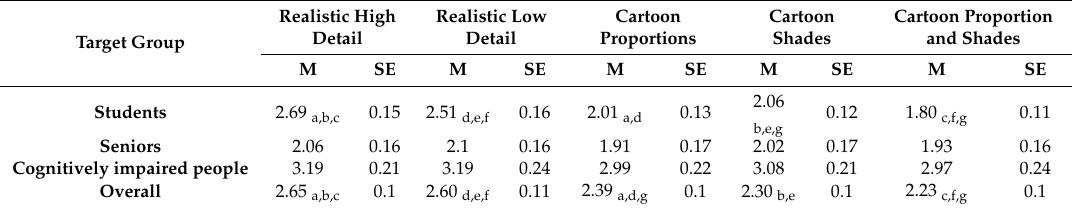
Table 5. Participant’s usage intention of agents for degrees of realism from all target groups. Target